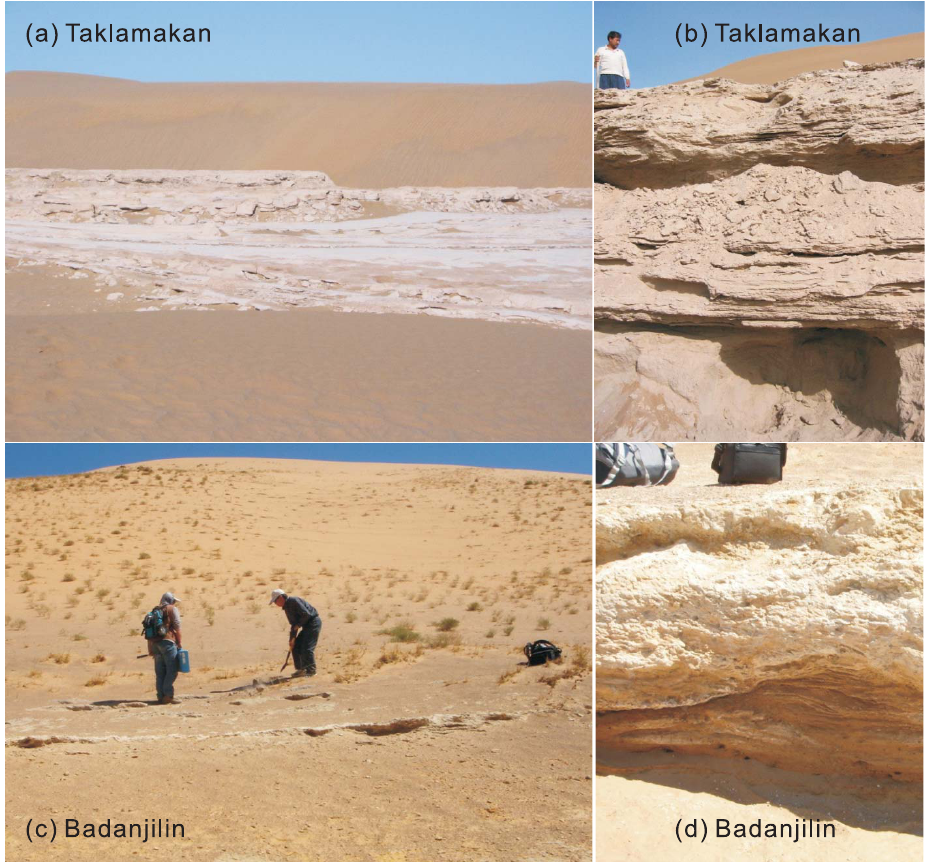
Figure 2. Photograph views of Quaternary and modern sediments of aeolian and lacustrine/fluvial facies that consisted of clay and sand/silt sand alternations in the Taklamakan and Badain Jaran deserts. (a) and (b) the Taklamakan Desert, (c) and (d) the Badain Jaran